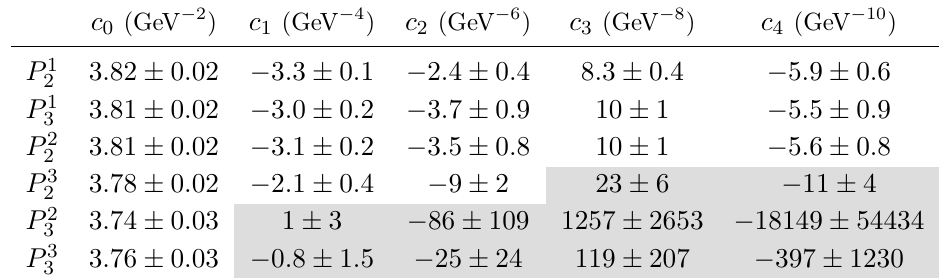
Table 2 . Values for the first five Taylor coefficients c n of the gluon propagator predicted by the Padé approximants (with statistical errors). Shaded results have uncertainties larger than 25% and do not enter our final